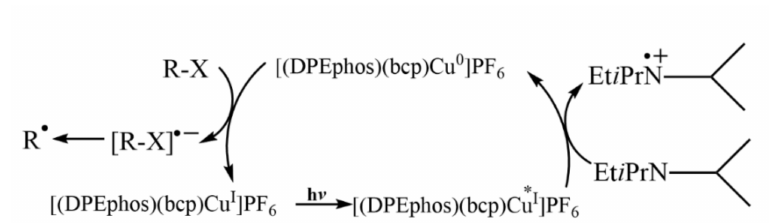
Figure 4. The mechanism of visible-light-driven aryl halides reduction with [(DPEphos)(bcp)Cu]PF 6 as photosensitizer. Reprinted with permission from Ref. [29]. Copyright 2017 American Chemical Society.